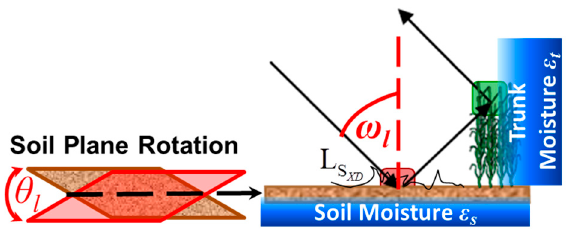
Figure 1. Conceptual visualization of the depolarizing soil-trunk double-bounce scattering including the different input variables for extended Fresnel scattering: ω l = local incidence angle, θ 1 = rotation limit angle of soil plane, L SXD = roughness intensity loss factor.